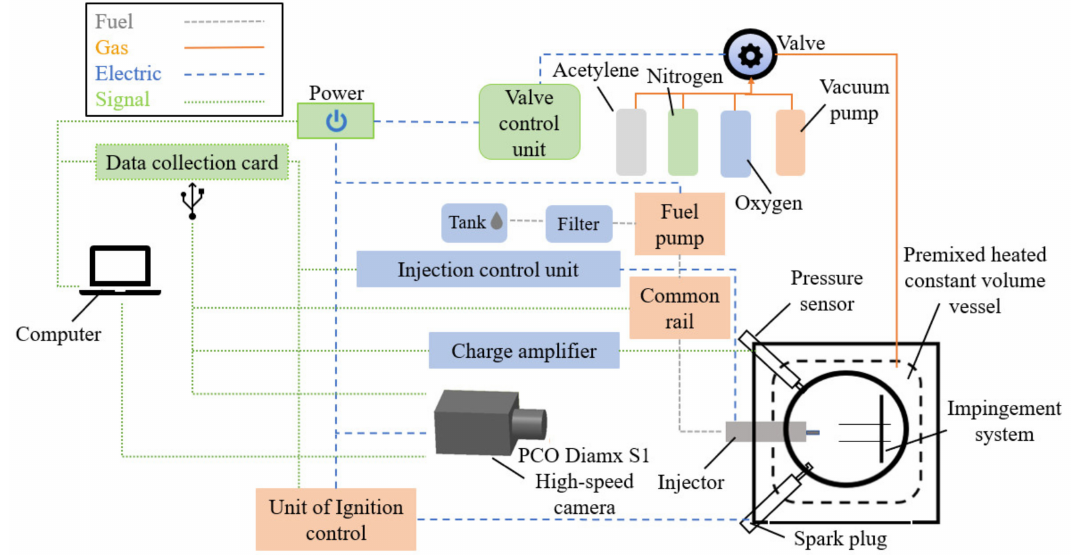
Figure 1. Diagram spray and combustion visualization experiment